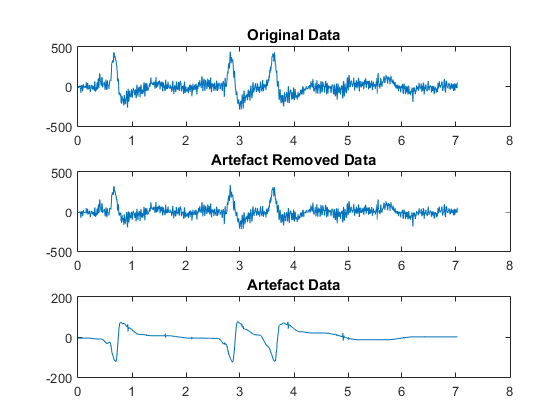
Fig. 5. Original Data, Artifact Removed Data and Artifact Data